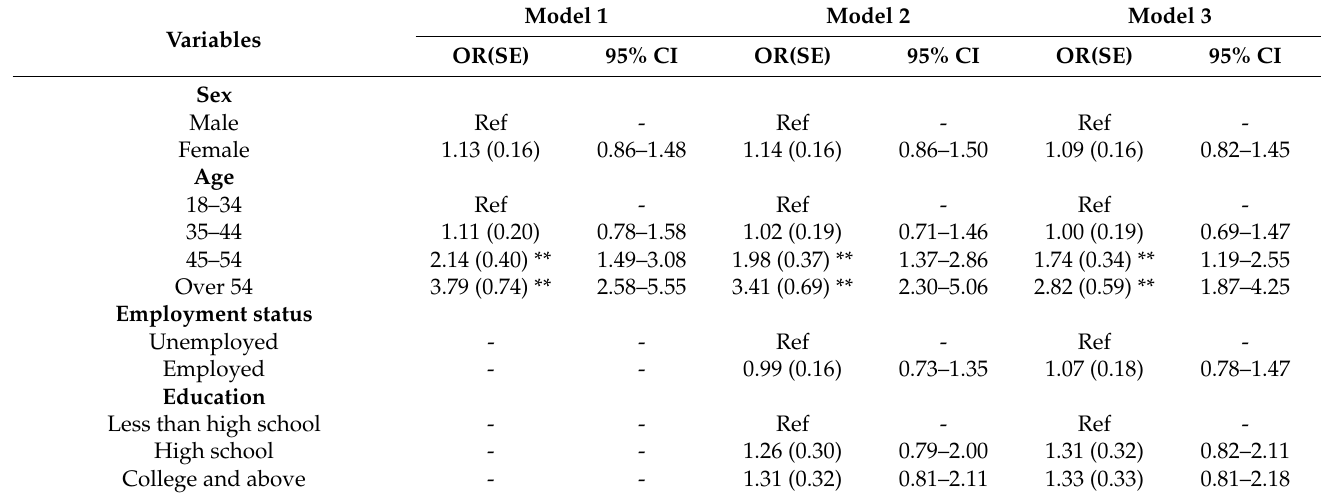
Table 2. Logistic Regression Models for COVID-19 Vaccine